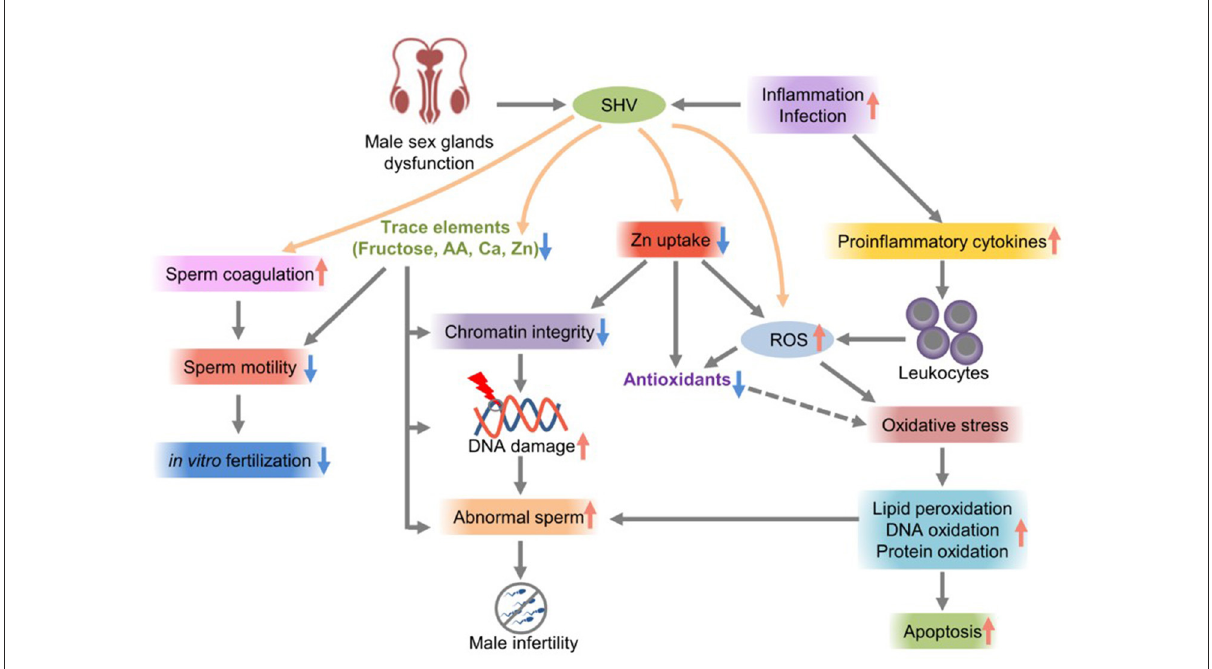
FIGURE1 The effects of SHV on male infertility.